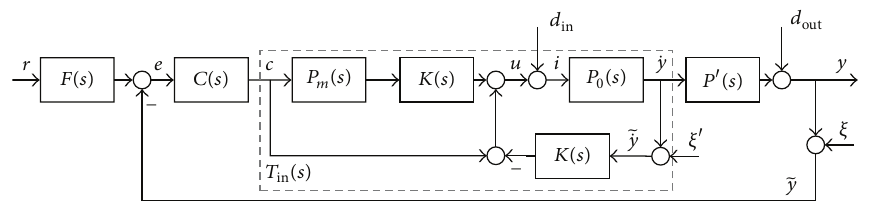
Figure 1: Disturbance observer in an RIC